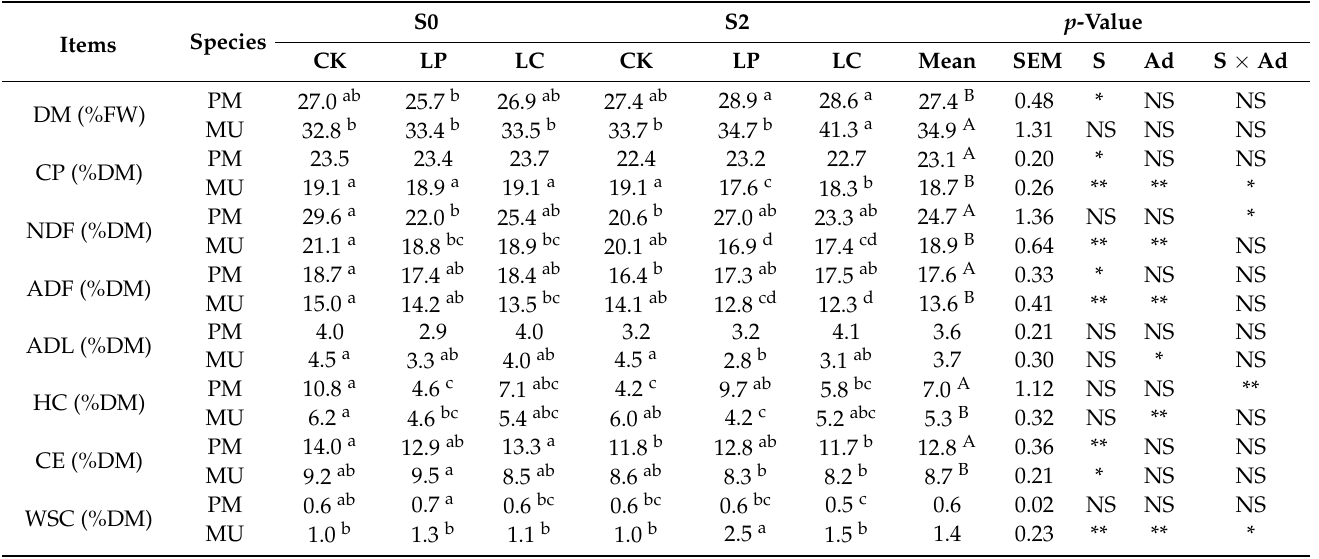
Table 3. The effect of sucrose and additives on chemical composition of woody forage